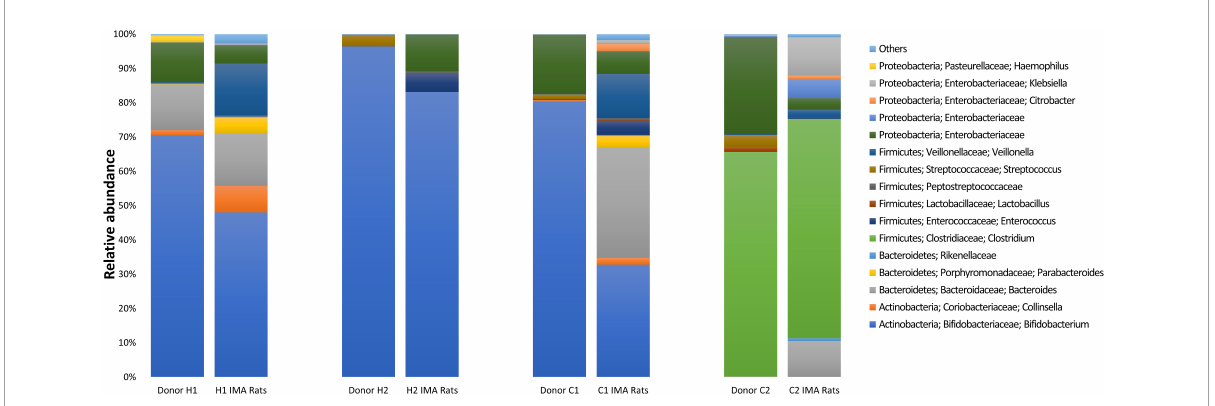
FIGURE2 Bacterial community composition was determined by 16S rRNA gene amplicon sequencing in feces from infant donors and respective infant microbiota-associated (IMA) rats. For IMA rats, each column represents the average relative abundance. The relative abundance of taxa with an average relative abundance of > 0.1% are depicted with the taxa nomenclature; lower abundant taxa ( < 0.1%) are shown as Others.